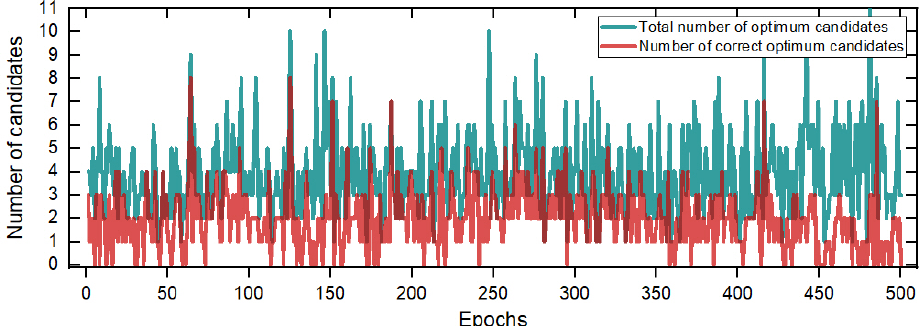
Figure 8. Number of optimum candidates with z coordinate fixed to referenced